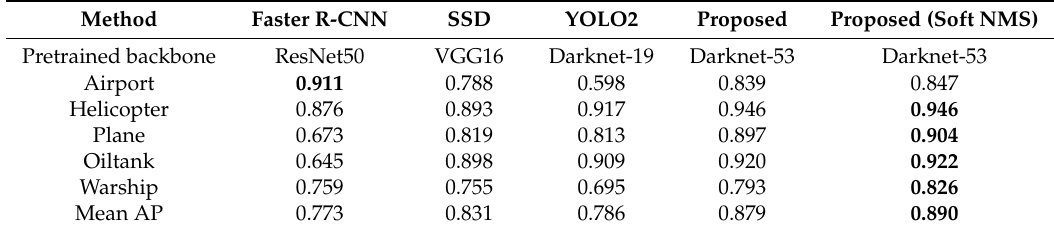
Table 2. The average precision (AP) values of compared object detection methods on RSD-GOD dataset.